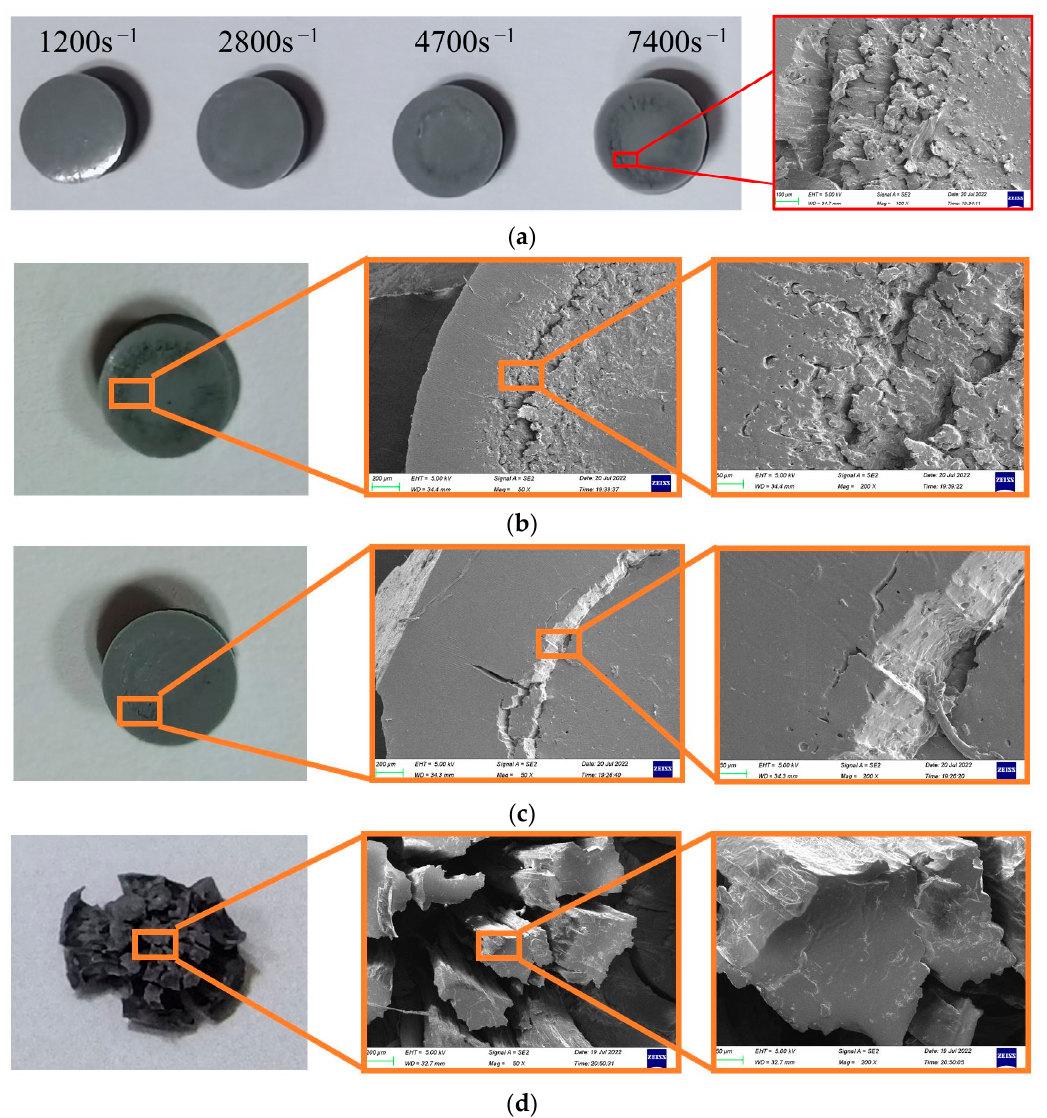
Figure 6. Damage morphology of silicone rubber after impact: ( a ) Damage morphology of the silicone rubber at the same temperature (26 °C) and different strain rates; ( b ) Typical damage micromorphology of silicone rubber at a low temperature (200 °C, 7400 s − 1 ); ( c ) Typical damage micromorphology of silicone rubber at a low temperature ( − 40 °C, 7400 s − 1 ); ( d ) Damage morphology of the silicone rubber after impact at higher speeds (26 °C).